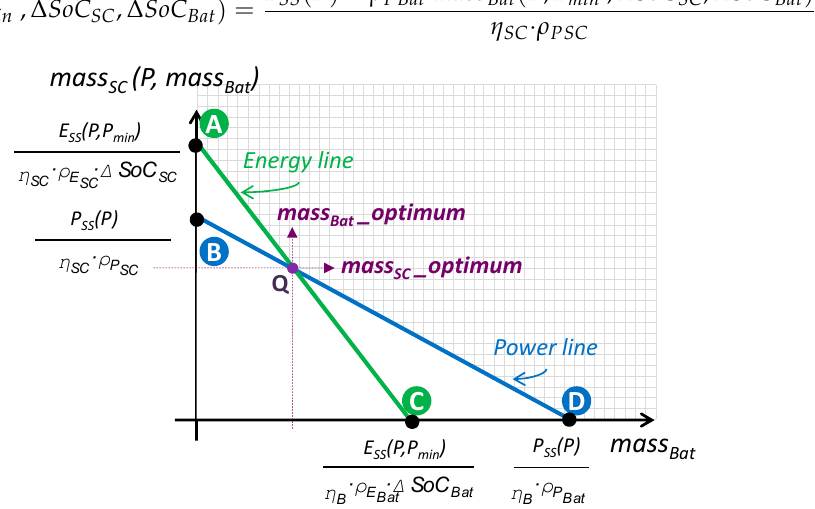
Figure 3. Equations system graphic solution in the first quadrant.